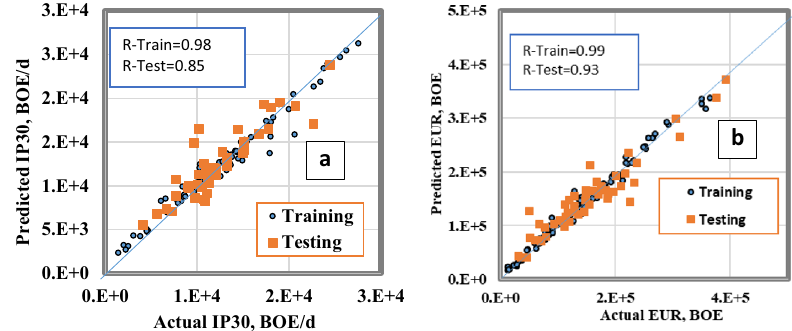
estimated RF results for a IP30 model and b EUR